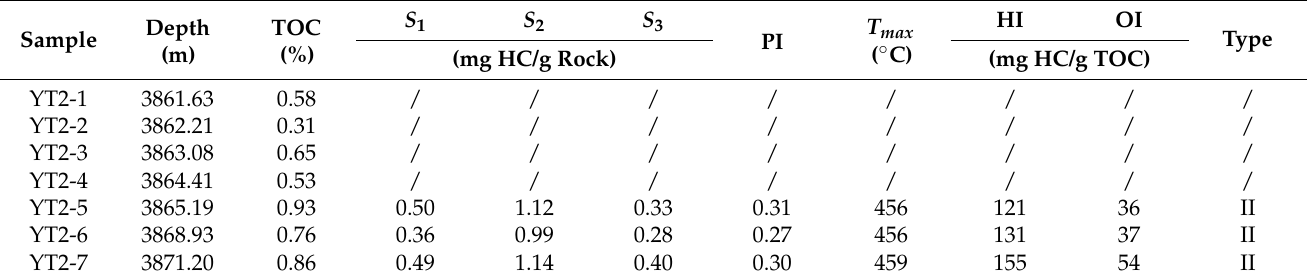
Table 3. Rock pyrolysis analysis of black shale samples from the Wulalike Formation.